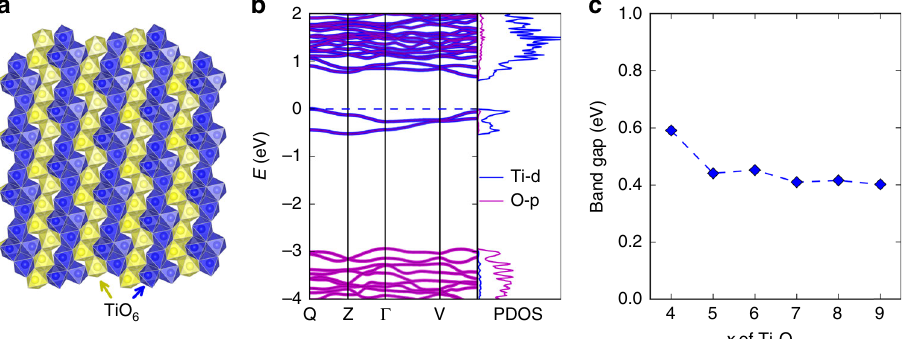
Fig. 5 Structural and calculated electronic properties of Magnéli phases. a Schematic illustration of the crystalline structure of Ti 4 O 7 . See text and Supplementary Fig. 8. b Calculated band structure and (orbital) projected density of states ( PDOS ) of Ti 4 O 7 . c Calculated band gaps of the Magnéli phases Ti x O 2 x − 1 as the function of